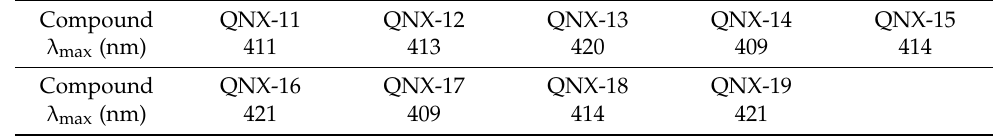
Table 6. Optical properties of the QNX-11-QNX-19 series in 1-methyl-2-pyrrolidone.